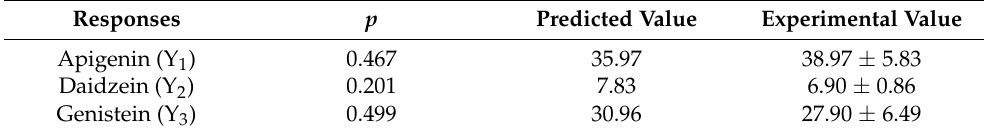
Table 3. Experimental and predicted response values at optimal conditions of pH 7.02 and 29.99 ◦